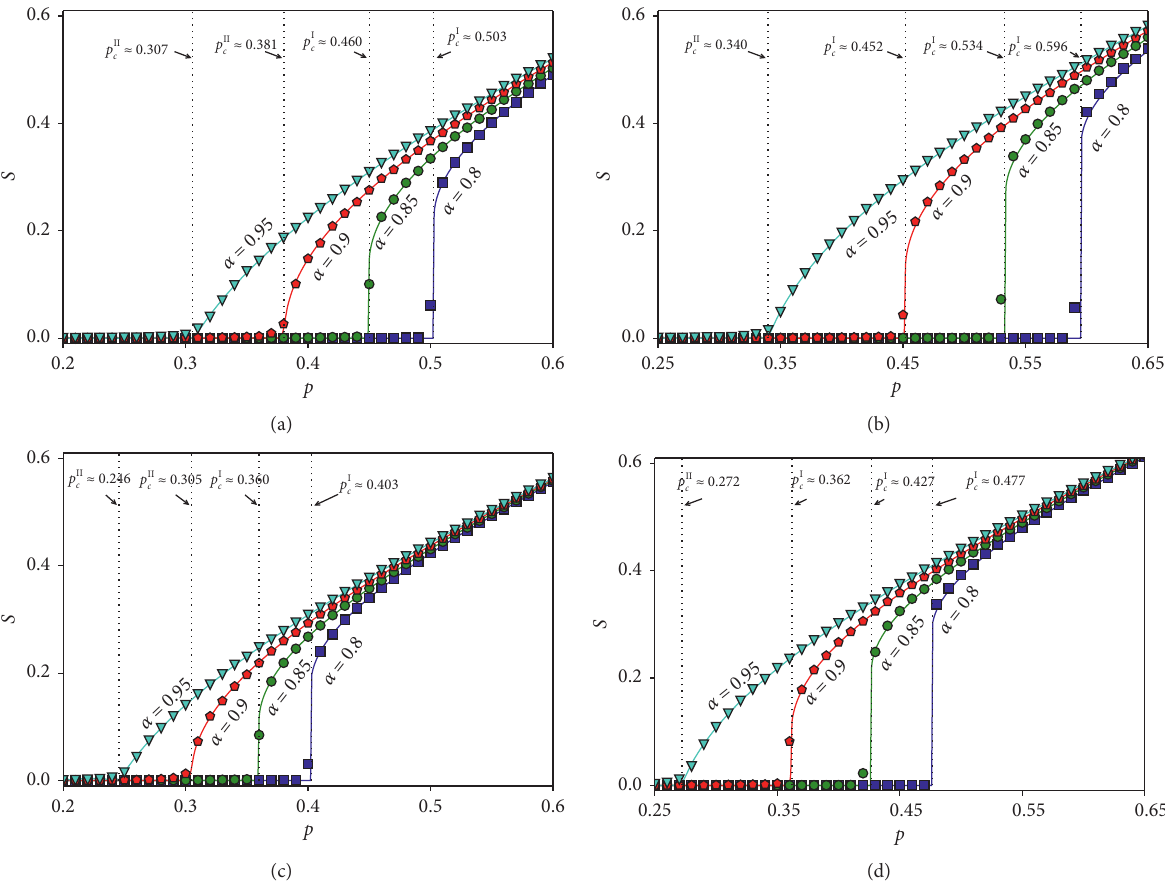
Figure 3: Simulation results for percolation transitions on three-layer and four-layer random networks. (a), (b) The results for three-layer and four-layer random networks with 〈 k 〉 � 4, respectively. (c), (d) The results for three-layer random networks and four-layer random networks with 〈 k 〉 � 5, respectively. The results were obtained by averaging over 100 independent realizations, and the network size was N � 10 5 . The solid lines behind the symbols denote the theoretical predictions that were obtained by equations (1) and (2). The vertical dashed lines denote the first- and second-order percolation transition points predicted by equations (5) and (7),